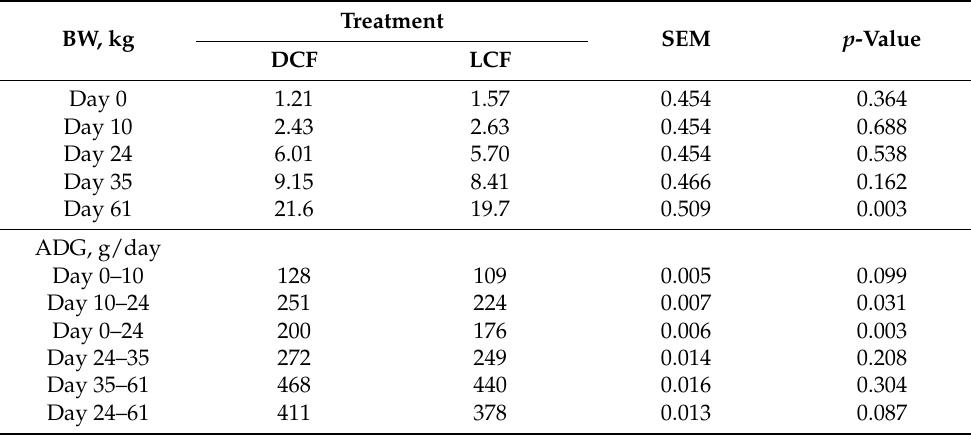
Table 4. Average BW and ADG of pigs fed a dry (DCF) or liquid (LCF) creep feed from day 10–24. After weaning all pigs were fed a dry diet. BW,